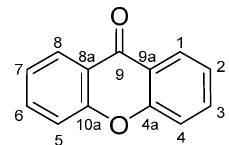
Figure 1. Xanthone Figure 1. Xanthone scaffold.